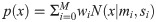
Distribution of the unambiguous standardized Gini indices (UGini) of countries as estimated by the World Bank based on income.Top left: The density distribution is presented as probability density function, estimated by means of the Pareto Density Estimation (PDE [19]; black line). A Gaussian mixture model (GMM) given as p(x)=Σi=0MwiN(x|mi,si), where mi, si and wi are the parameters mean, standard deviation and relative weight of each of the Gaussians, respectively, was fit (red line) to the data, with a number of mixes of M = 4 (Gaussian, G #1 .. G #4) shown as differently colored lines. The Bayesian boundaries between the Gaussians are shown as perpendicular magenta-colored lines. Top right: A quantile-quantile plot comparing the observed distribution of standardized Gini indices with the distribution expected from the GMM (abscissa). Bottom: World map showing the countries classified for Gini index categories. The four categories correspond to the four Gaussian modes identified to best describe the distribution of the standardized Gini indices. The Gini index increases with the number of the category and low Gini index values are shown in green while high Gini index values are shown in dark red. Empty (white) regions indicate either lack of information or information judged as of poor quality by the publisher. The Fig has been created using the R software package (version 3.4.0 for Linux; http://CRAN.R-project.org/ [18]); specifically, the GMM was drawn using our R package “AdaptGauss” (https://cran.r-project.org/package=AdaptGauss [25]) and the world map was drawn using the “mapCountryData” function of the R package “rworldmap” (South A.; https://cran.r-project.org/package=rworldmap [36]).